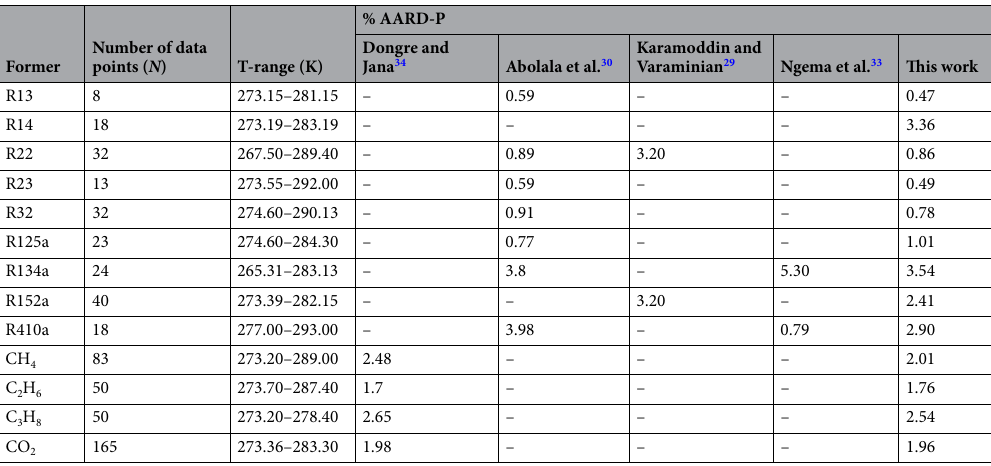
Table 6. A comparison of the %AARD-P values for hydrate equilibrium predictions for pure refrigerant hydrate formers.